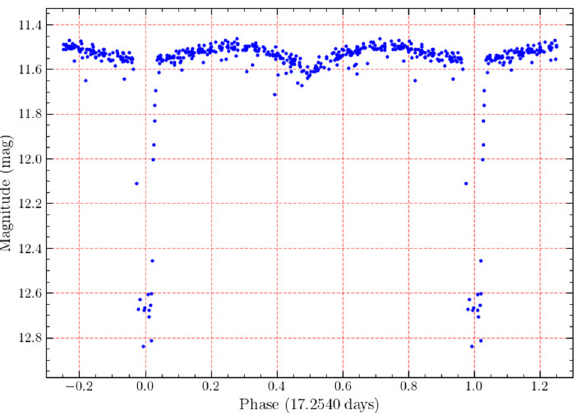
Figure 3: Light curve for HU Per based on ASAS - SN data converted to the period.